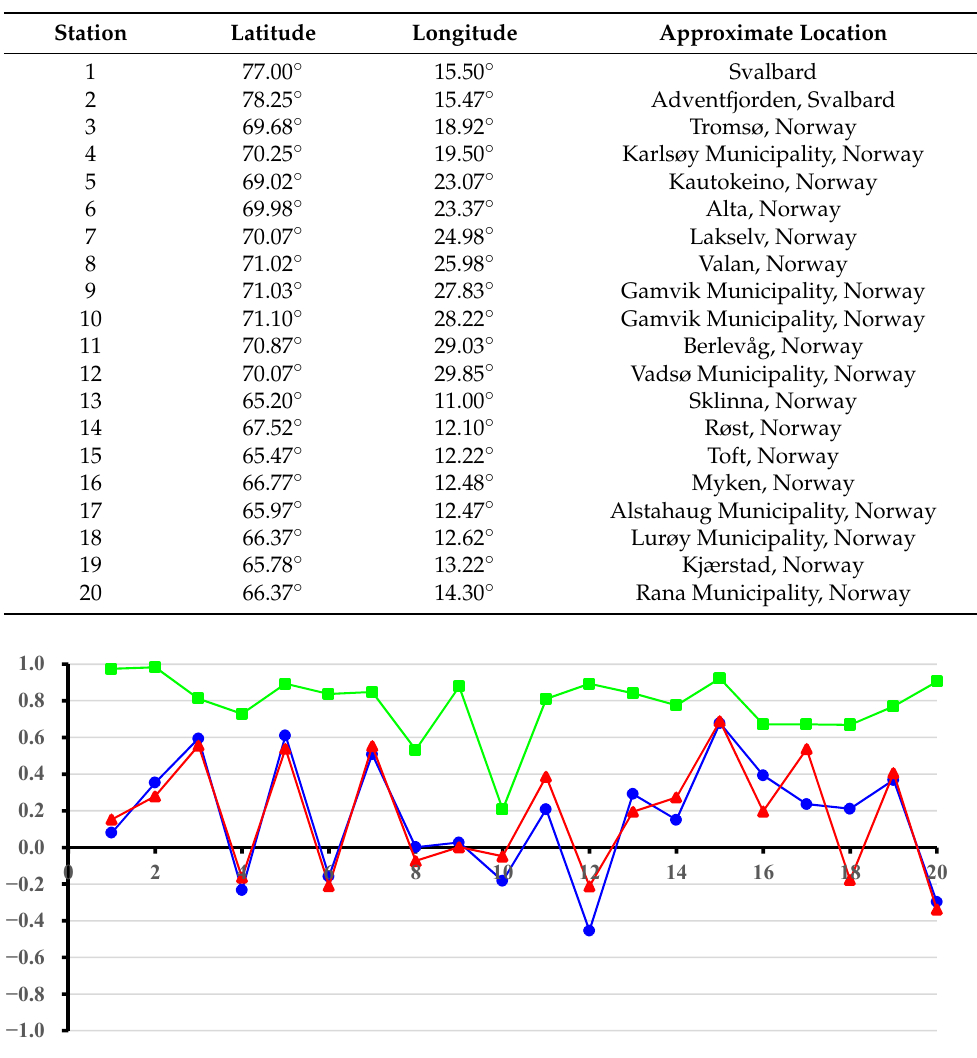
Table 3. A list of stations selected for an example of cross–correlations between hydroclimatic processes and their locations.